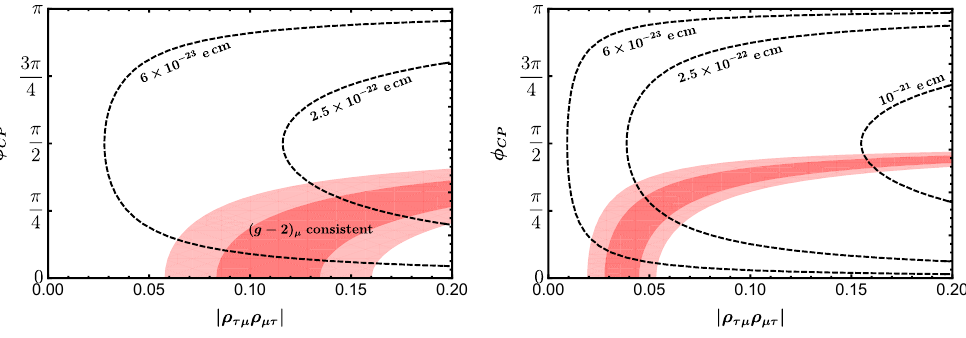
Figure 5 . Correlation between muon g − 2 and µ EDM. Pink (light pink) region shows parameter space that explain eq. (5.1) at 1 σ (2 σ ) , while dashed lines are d µ contours. The left (right) plot is for c γ = 0 , m H = 300 GeV and m A = 340 (500) GeV. All other ρ ij are set to